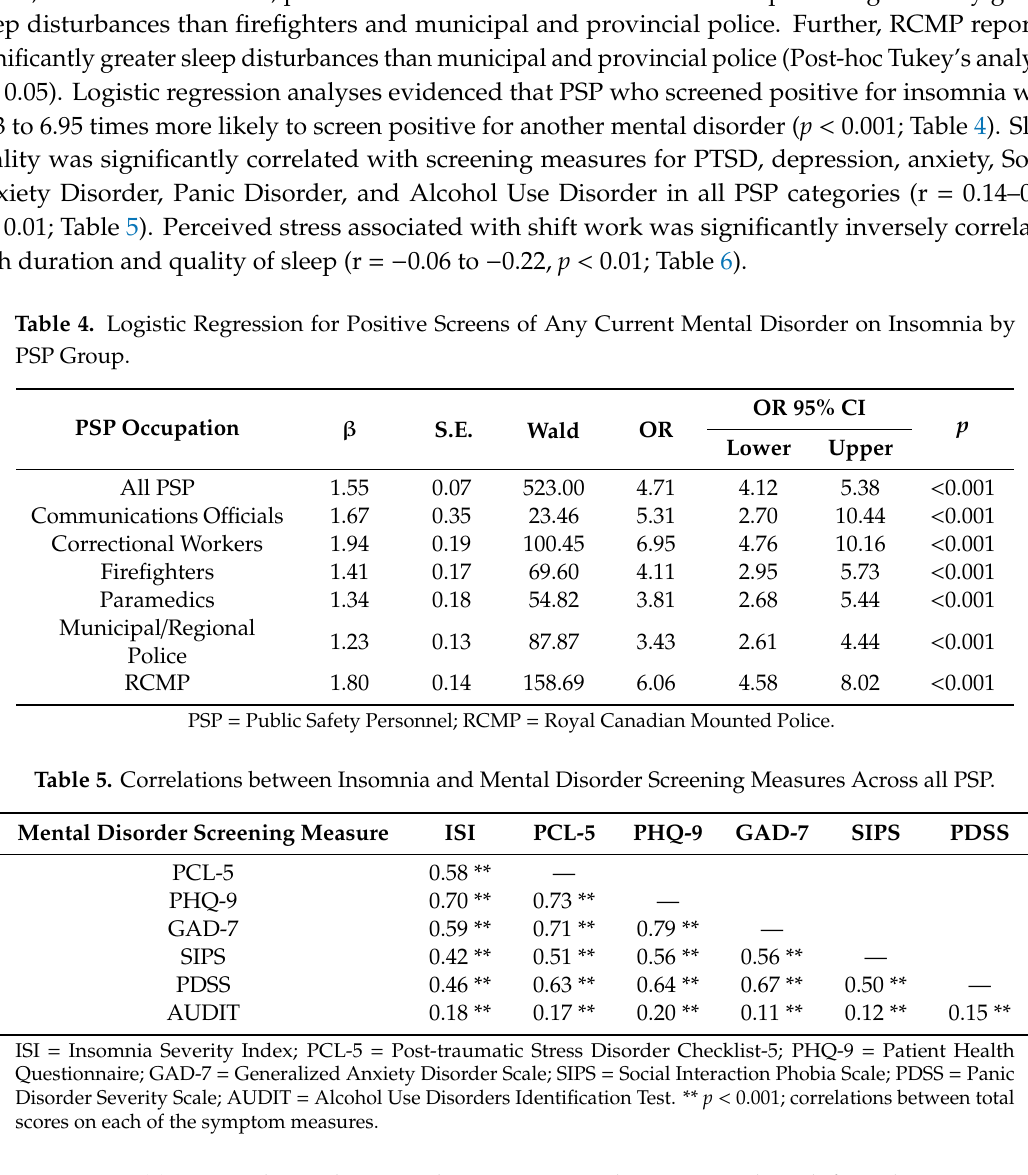
Table 6. Correlations between Sleep Measures and Stress Regarding Shift Work. Shift Work Hours of Sleep Hours of Sleep Sleep Quality Measure Stress Work Nights O ff -Shift